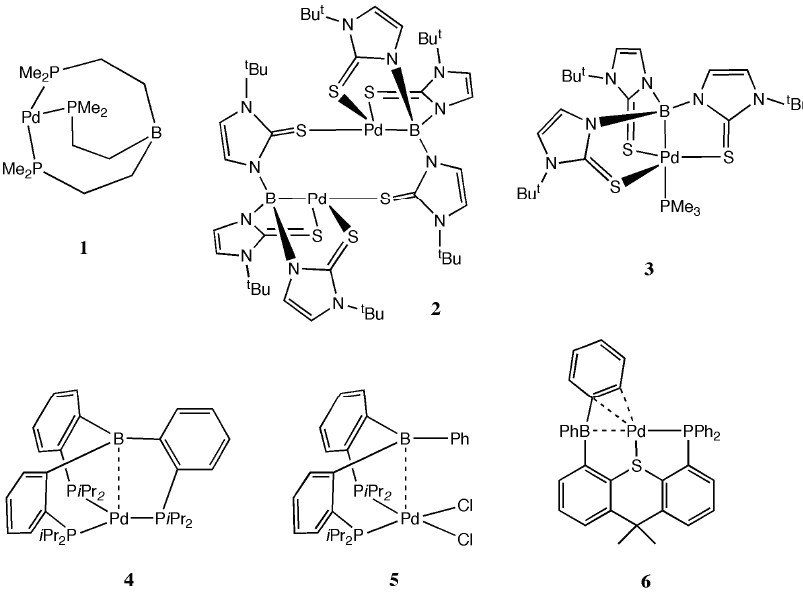
Figure 1. Known L-Pd-Z complexes as reported in the